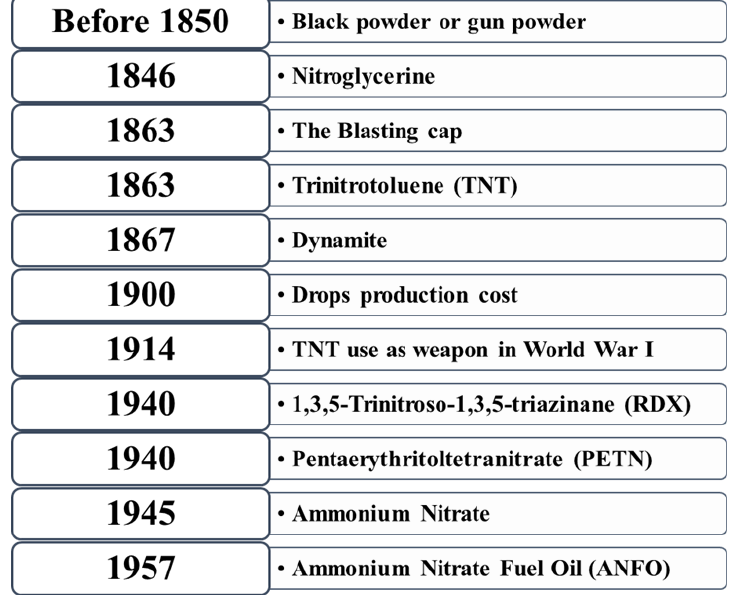
Figure 3. Chronological history of explosives